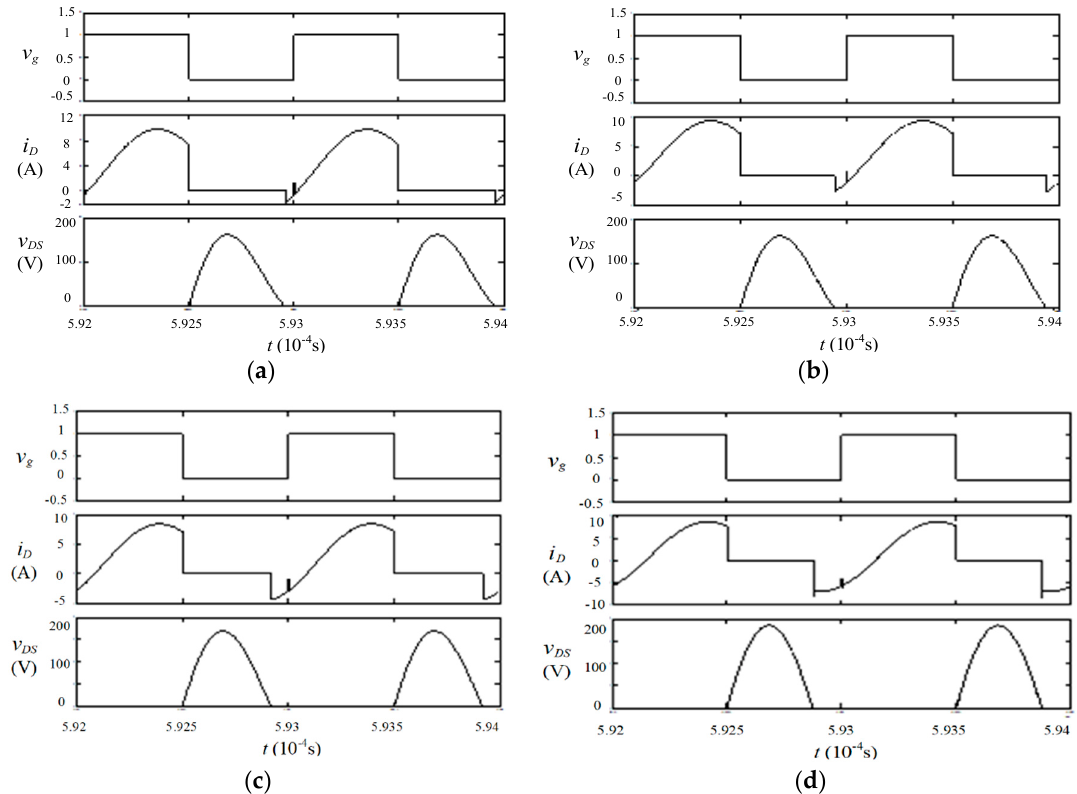
Figure 8. Switching states with various distance between the receiver coil and iron plate. ( a ) d 1 = 20 cm; ( b ) d 1 = 15 cm; ( c ) d 1 = 10 cm; ( d ) d 1 = 5 cm.